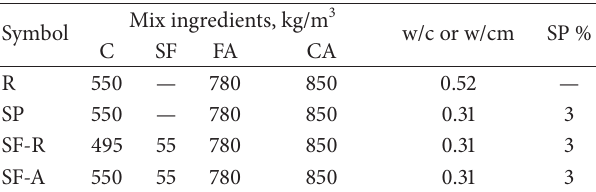
Table 2: Proportion of concrete